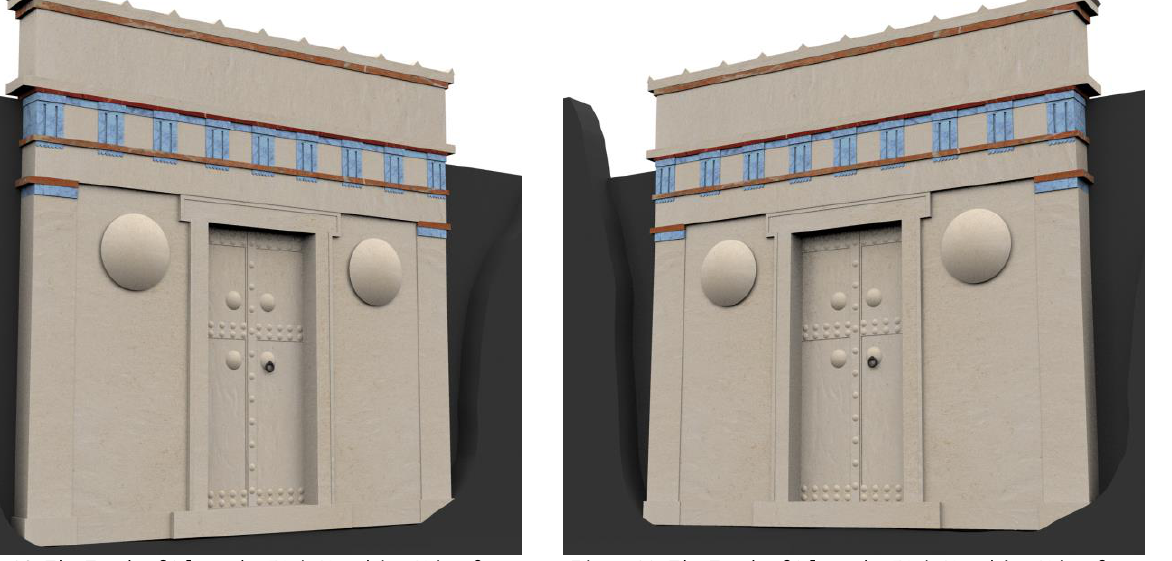
Figure 28. The Tomb of Alexander IV in Verghina. View from the west. Detail of the 3D model.